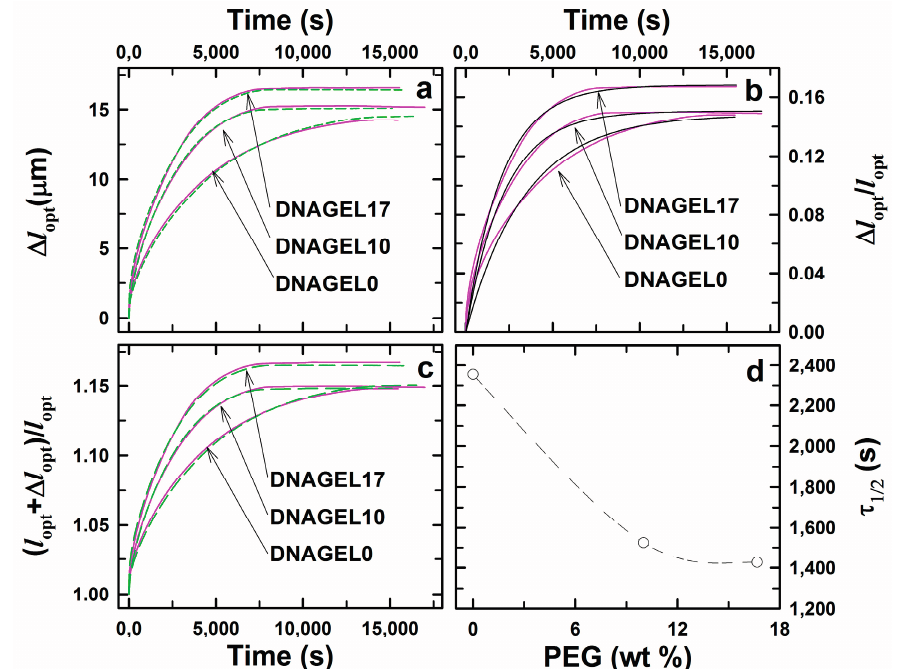
Figure 6. Optical length changes ( Δ l opt ) ( a ) and optical length changes relative to the optical length at reference state (( l opt + Δ l opt )/ l opt ( c ) of DNA hybrid hydrogels with an altered pore size distribution upon ssDNA probe recognition. Fits of first order swelling kinetics (black lines) to relative optical length changes ( Δ l opt / l opt , pink lines) ( b ) were the basis for the estimation of apparent equilibration time constants ( τ 1/2 = ln2/k) ( d ). DNA hybrid porous hydrogels consisted of 10 wt % AAm, 0.6 mol % Bis (relative to AAm) and 0.4 mol % S-B double-stranded oligonucleotides (relative to AAm) synthesized in the presence of 0 (DNAGel0, l opt = 96.2 µm), 10 (DNAGel10, l opt = 101.8 µm) and 17 wt % (DNAGel17, l opt = 99.1 µm) of PEG200. All measurements were carried out with a probe nucleotide concentration of 20 µM in buffer solution at room temperature and at least two times (red and green lines for each experimental